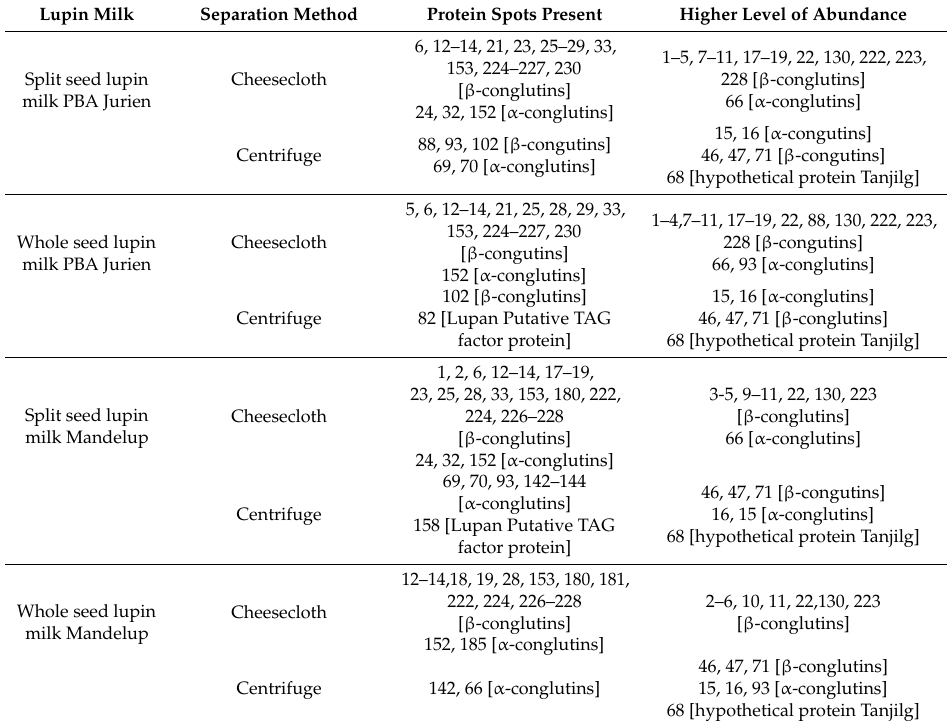
Table 4. List of the lupin proteins compared between cheesecloth and centrifuge filtration with respect to protein spots and their